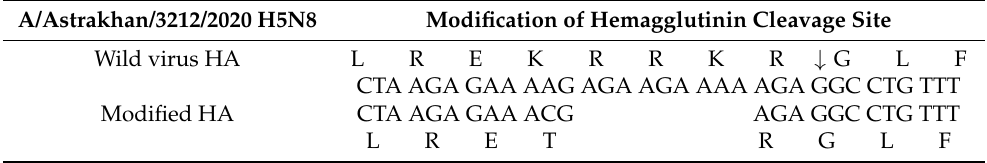
Table 1. Hemagglutinin cleavage site of reassortant